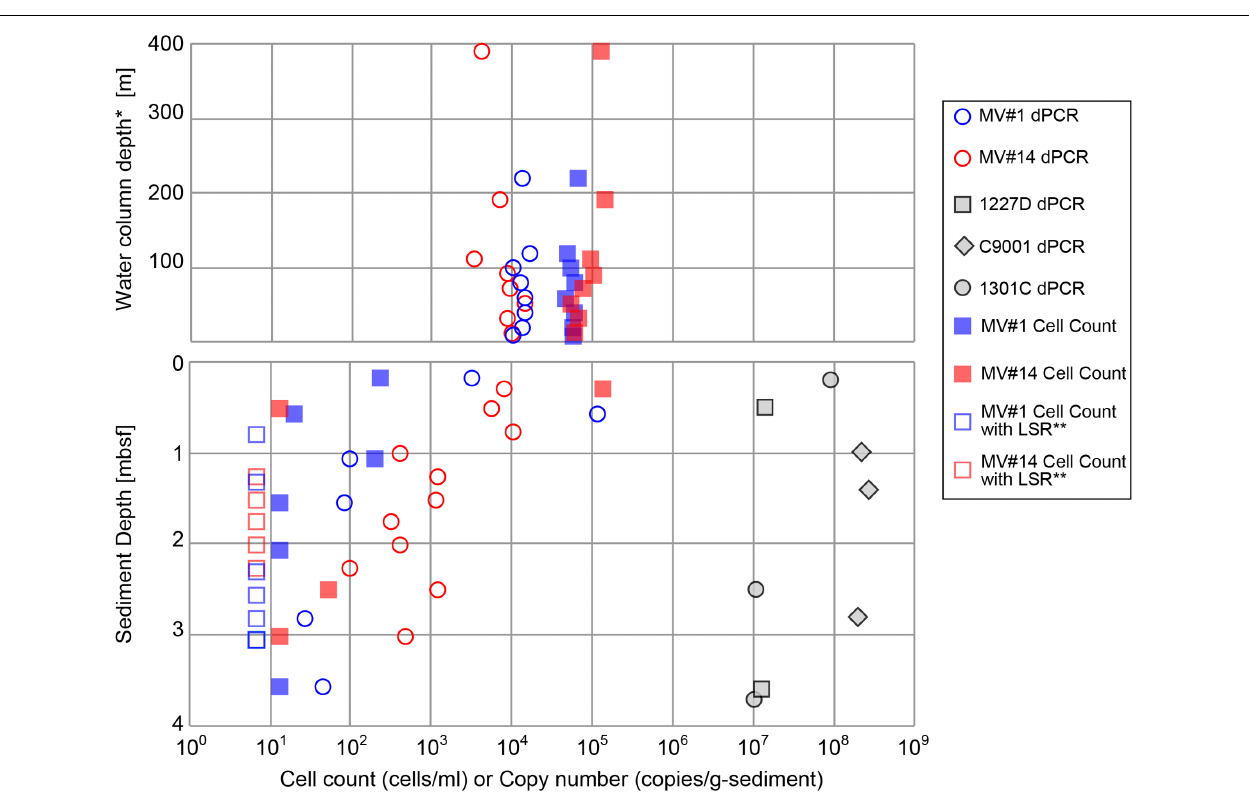
FIGURE 3 | Microbial cell counts by SYBR Green I staining, and digital PCR (dPCR) quantification of 16S rRNA gene abundance. dPCR results are the sum of bacterial and archaeal 16S rRNA gene abundance. dPCR results from reference sites from previous drilling expeditions are provided for comparison (see Table 1 for sampling site information). ∗ Height above the summit of the SMVs. ∗∗ LSR, “low statistical reliability” because of very low, but detectable, cell